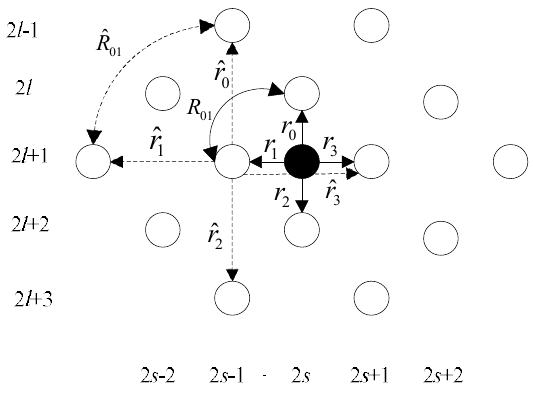
Figure 6. The second stage of interpolation.